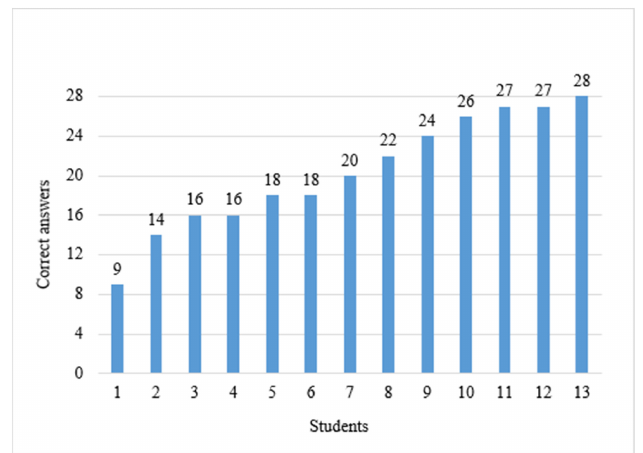
Figure 10. Third grade students’ performance (correct answers) in the pre-test.